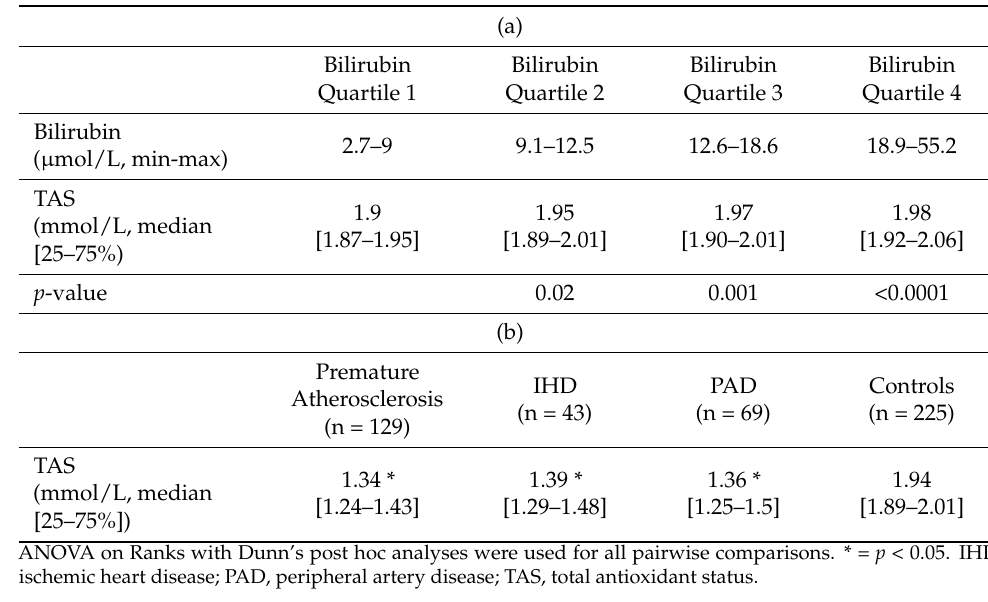
Table 5. ( a ) Relationship between serum bilirubin concentration and TAS in healthy controls. ( b ) Serum TAS in patients with various forms of atherosclerosis.